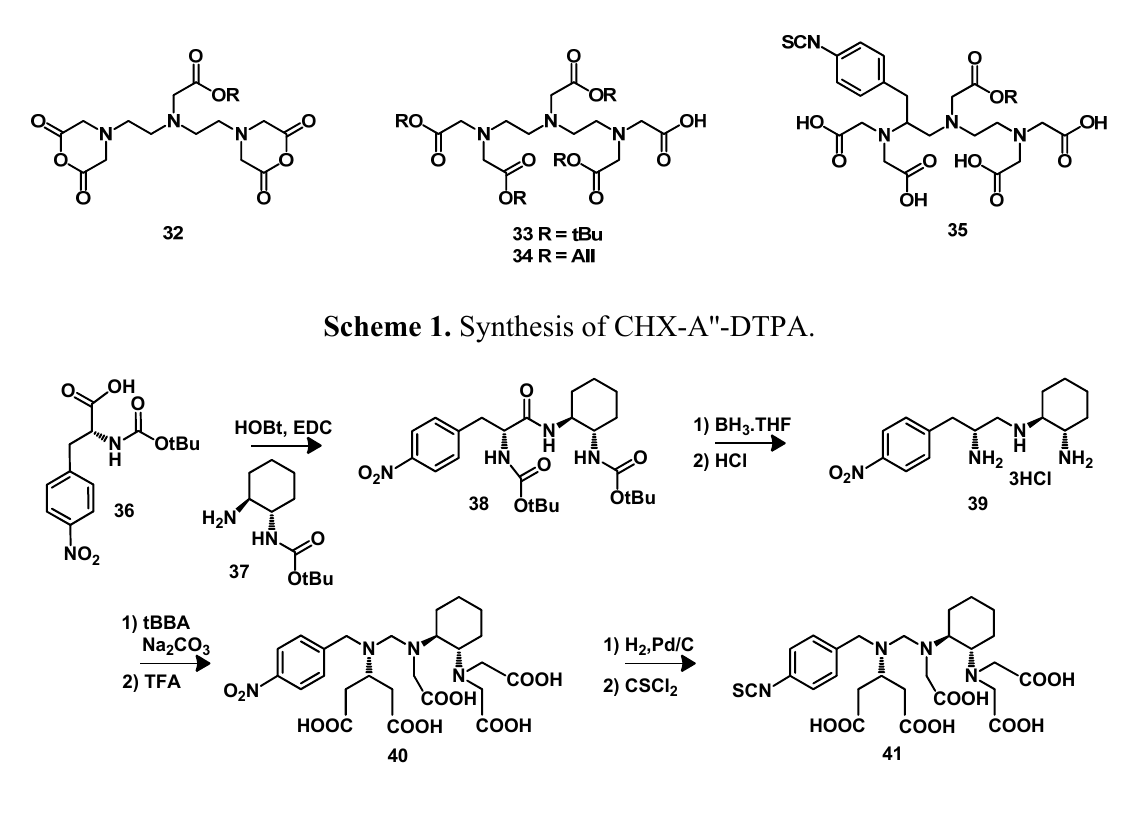
Figure 7. The chemical structure of BFCAs derived from DTPA.